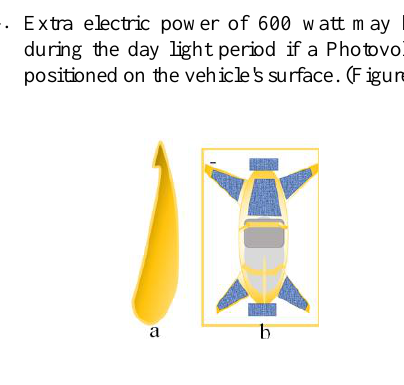
Figure 9 . a. Main vehicle body aerodynamics. b. Top view with blue PhotoVoltaic Film on the surface of the vehicle.